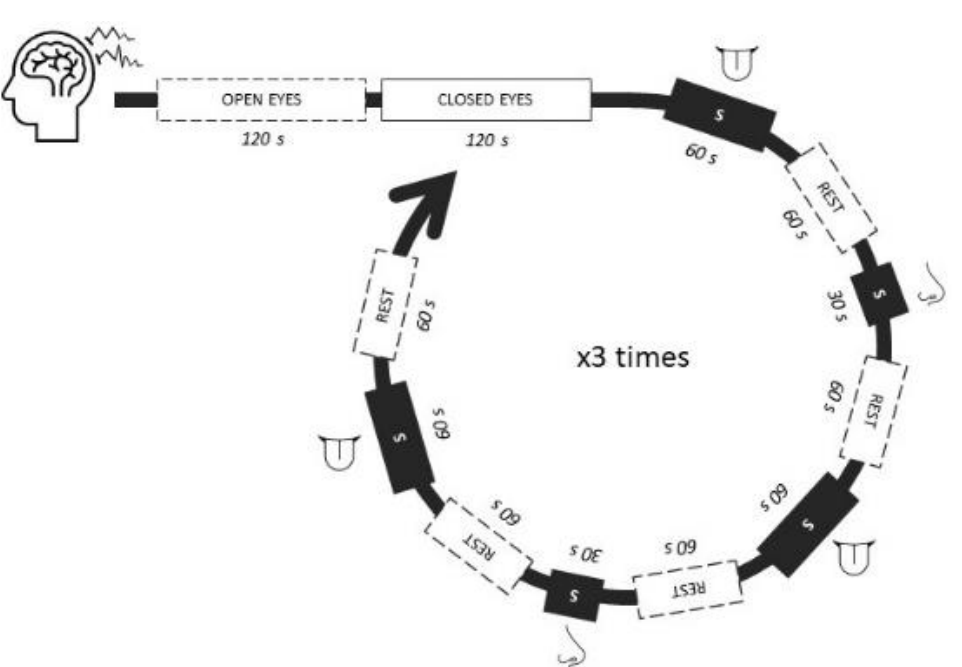
Figure 1. Example of one of the randomized paradigms during the EEG recordings. Legend: open and closed eyes periods were common in all participants; the rest of the sequence was presented in at least 3 different random orders to each participant.